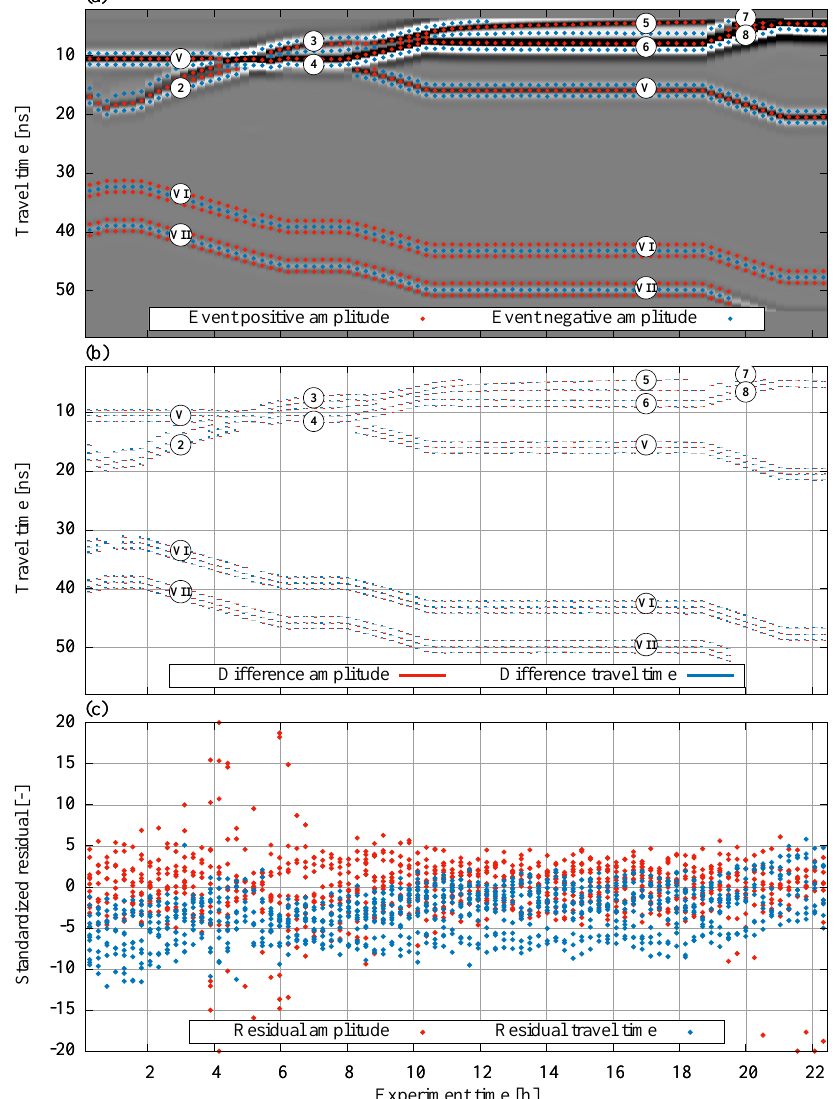
Figure 13. The evaluation of the synthetic GPR data is separated into three parts (a) shows the selected events (Sect. 2.3.3) which are evaluated with the optimization. The data shown are processed according to Sect. 2.3 except for the normalization. In contrast to the data that are evaluated, the shown radargram is normalized to its maximum absolute amplitude, facilitating the visual comparison of the traces. (b) shows resulting differences in travel time and amplitude of the mean parameter set. The differences in amplitude are given in arbitrary units which are consistently used in this study. For the synthetic data, these differences are practically invisible. For the measured data, however, they are more clearly recognizable (Fig. 13). (c) shows standardized residuals (Eq. 11), essentially zooming into the small differences given in (b) . Note that outliers are set onto the boundary. The markers are defined in Fig.